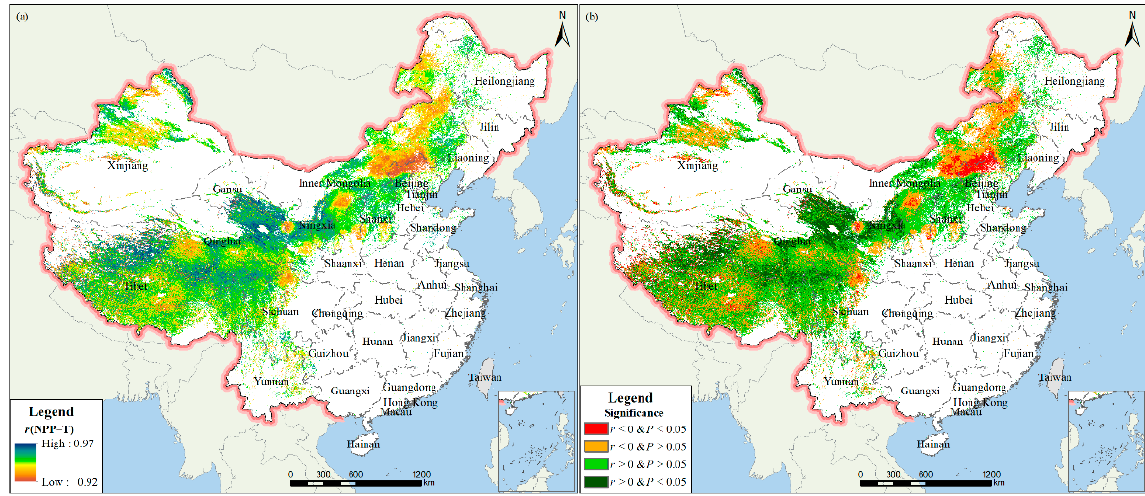
Figure 16. Spatial patterns of ( a ) partial correlation coefficients between ANPP and the average temperature in the growing season and ( b ) the corresponding significance levels.